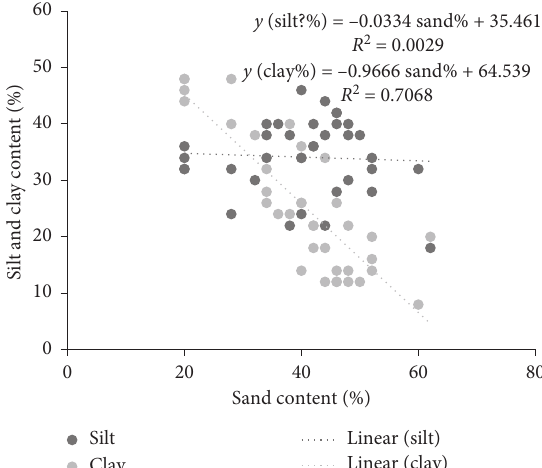
Figure 4: Linear regression between soil separates.